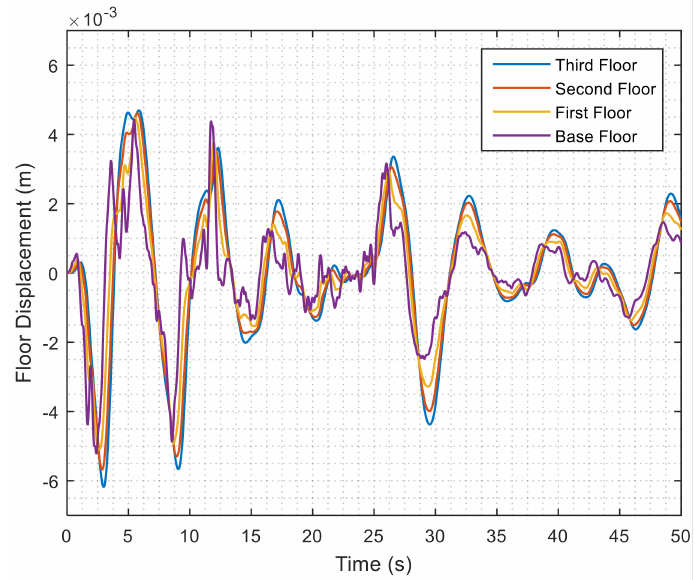
Figure 18. Structural Dynamic Response without Control.